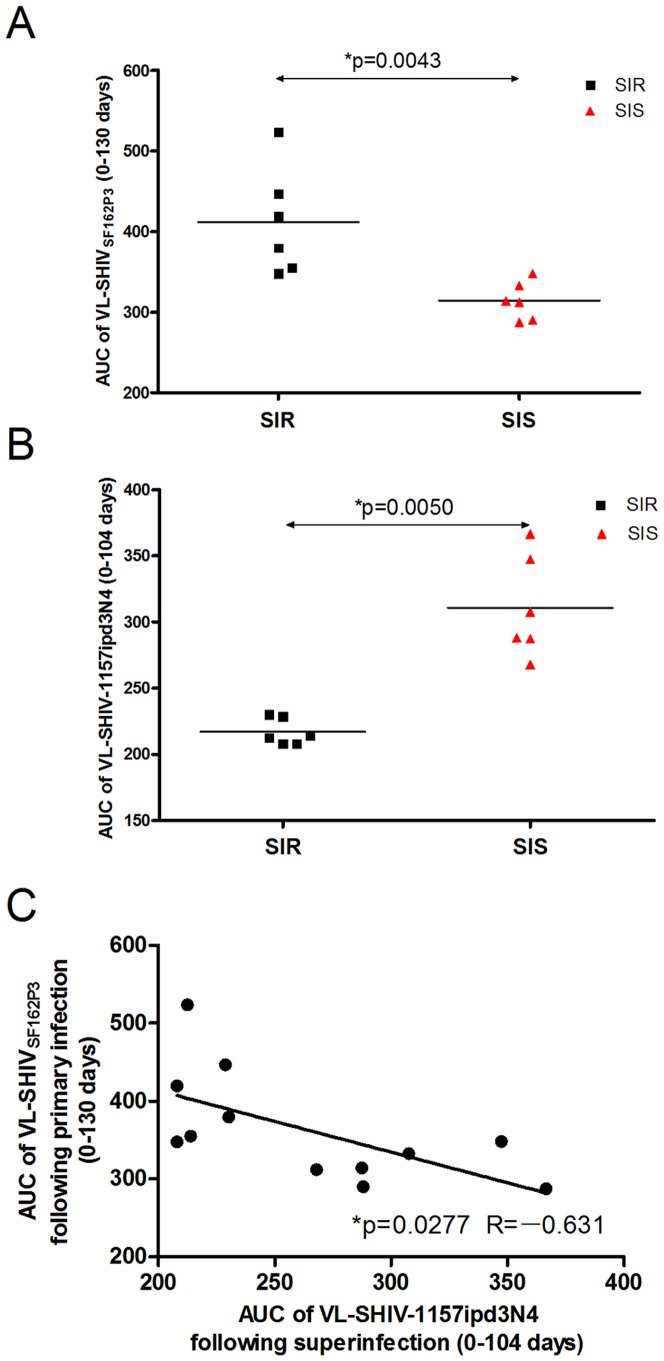
Repressive effect of SHIVSF162P3 replication on SHIV-1157ipd3N4 replication.(A) The AUC of SHIVSF162P3 viremia of SIS and SIR monkeys from day 0 to 130 after primary infection (Mann-Whitney U test, *P = 0.0043). (B) The AUC of SHIV-1157ipd3N4 viremia of SIS and SIR monkeys from day 0 to 104 after SHIV-1157ipd3N4 inoculation (Mann-Whitney U test, *P = 0.0050). (C) Correlation between the AUC of SHIVSF162P3 following primary infection and SHIV-1157ipd3N4 following superinfection (Pearson's correlation test, R = -0.631, *P = 0.0277).